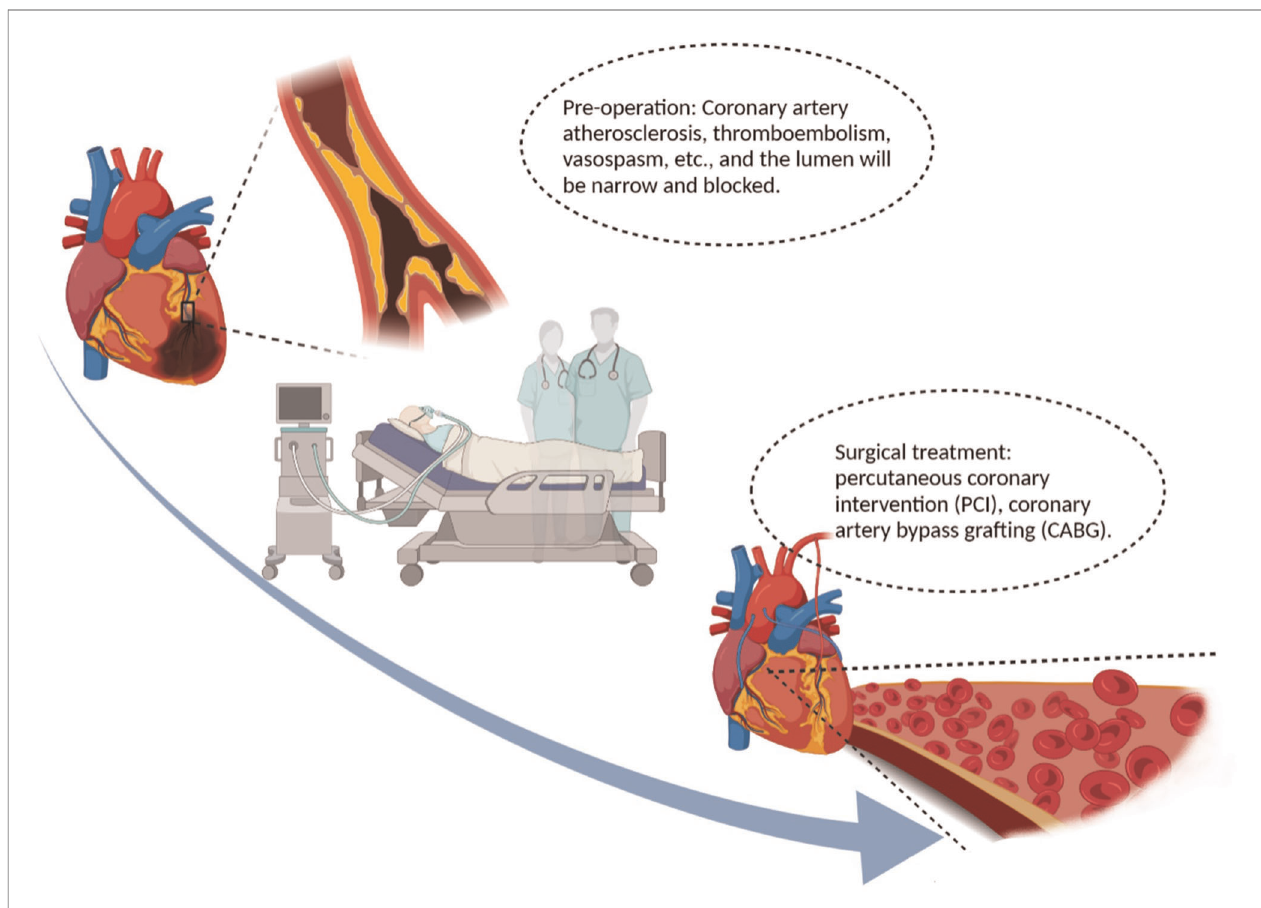
FIGURE 1 | Explanation before and after operation of coronary heart disease.